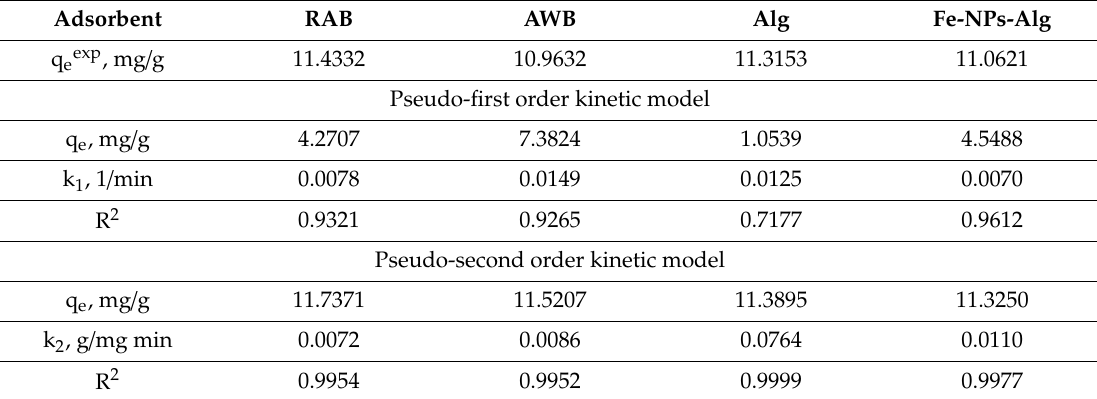
Figure 4. Linear dependences for pseudo-first kinetic model ( 1 ) and pseudo-second kinetic model ( 2 ) for Cu(II) ions adsorption on considered adsorbent materials (( a ): RAB; ( b ): AWB; ( c ): Alg; ( d ): Fe-NPs-Alg). Table 2. Parameter values of pseudo-first order and pseudo-second order kinetics models.